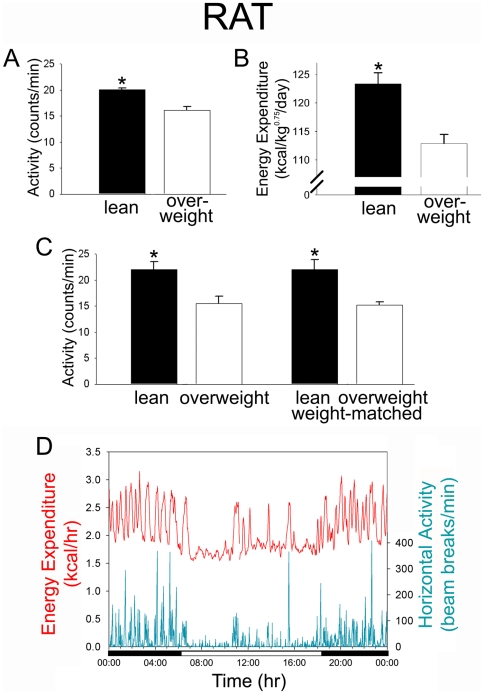
High-endurance rats were more active, regardless of body weight.Physical activity, in beam breaks/min over 24 hrs (mean±SE), was greater in lean, high-endurance rats compared to overweight, low-endurance rats (A), as was body mass-corrected energy expenditure (B). The same effect was seen in female high- and low-endurance rats, even when body weight did not differ between the two groups (C). Elevations in energy expenditure were seen at the same time as peaks in horizontal physical activity (lean rat shown here; D). *p<0.05.